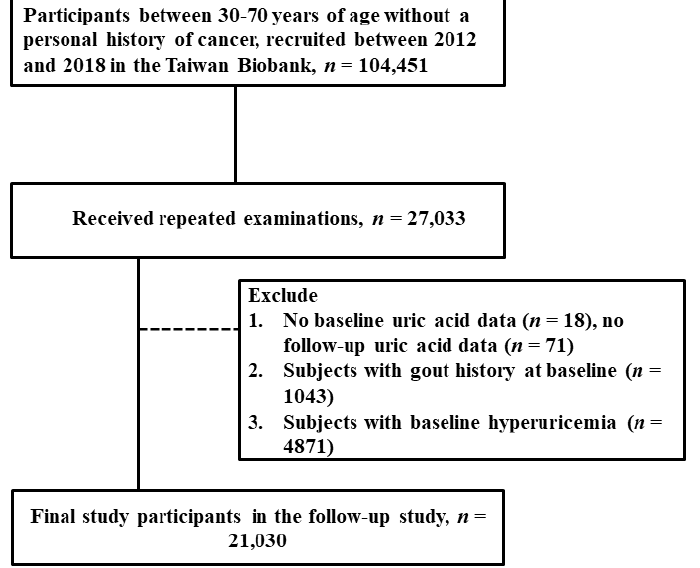
Figure 1. Flowchart of study population.